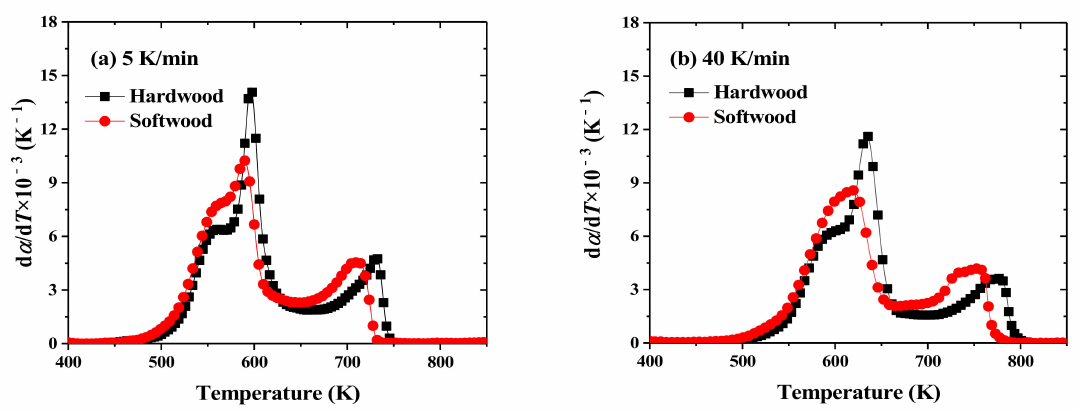
Figure 3. The d α /d T curves of beech and camphorwood under 5 and 40